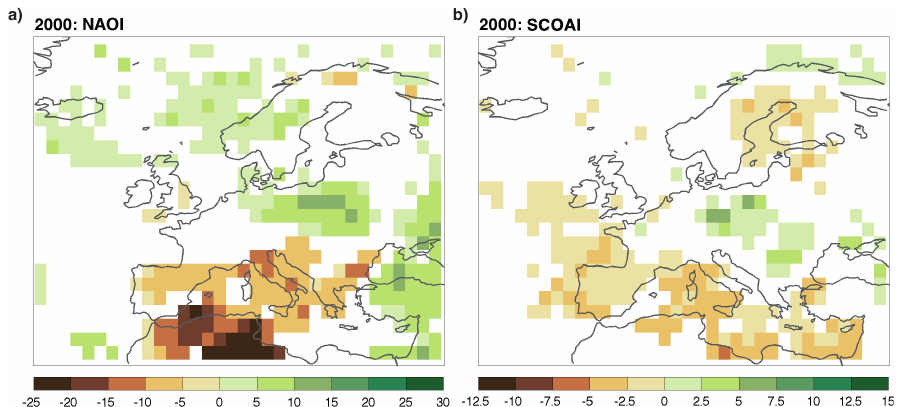
Figure B1. Rainy day anomalies (in %) per unit of NAOI (a) and CI time series (b) standard deviation. The CI time series has been constructed as described in Appendix B. The anomalies are calculated using a one-point regression analysis. Only differences significant at the 95% confidence level are shown. Note that the two panels use different colour scales.